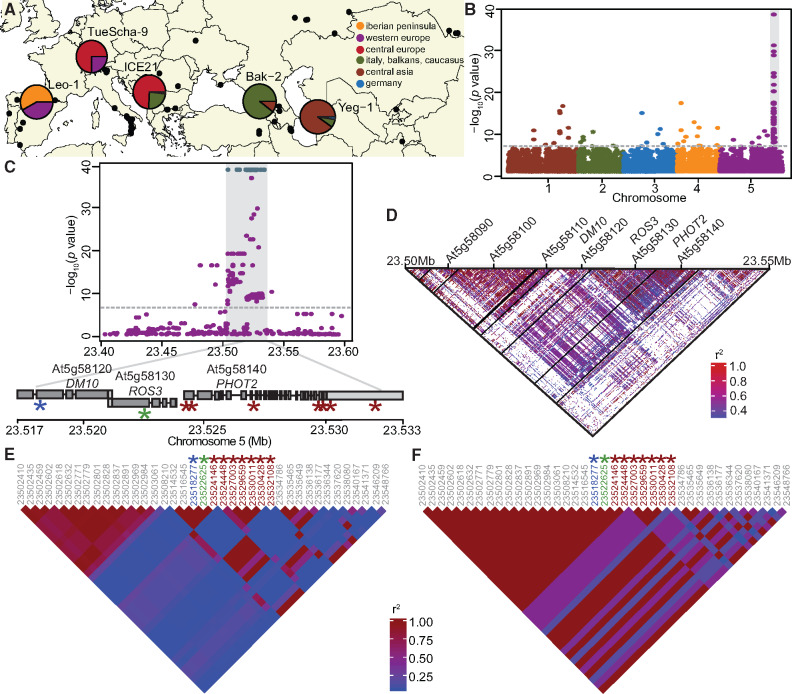
GWAS of hybrid necrosis in 80 accessions. (A) Map of 80 accessions (black dots), with the five risk accessions colored according to 1001 Genomes admixture groups (1001 Genomes Consortium 2016). (B) Manhattan plot for association of necrosis in Cdm-0 hybrid progeny when selfed and crossed to 79 other accessions. The significance threshold (Bonferroni correction, 5% family-wise error) is indicated as a horizontal dotted line (same in C). (C) Close-up of the region highly associated with hybrid necrosis; SNPs with a 1:1 association marked in teal. Asterisks indicate such 1:1 associations in At5g58120, ROS3, and PHOT2; see also (E) and (F). SNP positions are given in supplementary table S13, Supplementary Material online. (D) Linkage disequilibrium (LD) across a 50-kb region in chromosome 5. Strong linkage is observed from At5g58090 to At5g58140. (E) LD across the same 50-kb region as in (D), with a subset of markers from 80 accessions crossed to Cdm-0. Asterisks indicate markers highlighted in (C). (F) LD across a 50-kb region with the same markers as in (E), but for the five risk accessions only. Higher LD is seen here than in (E).